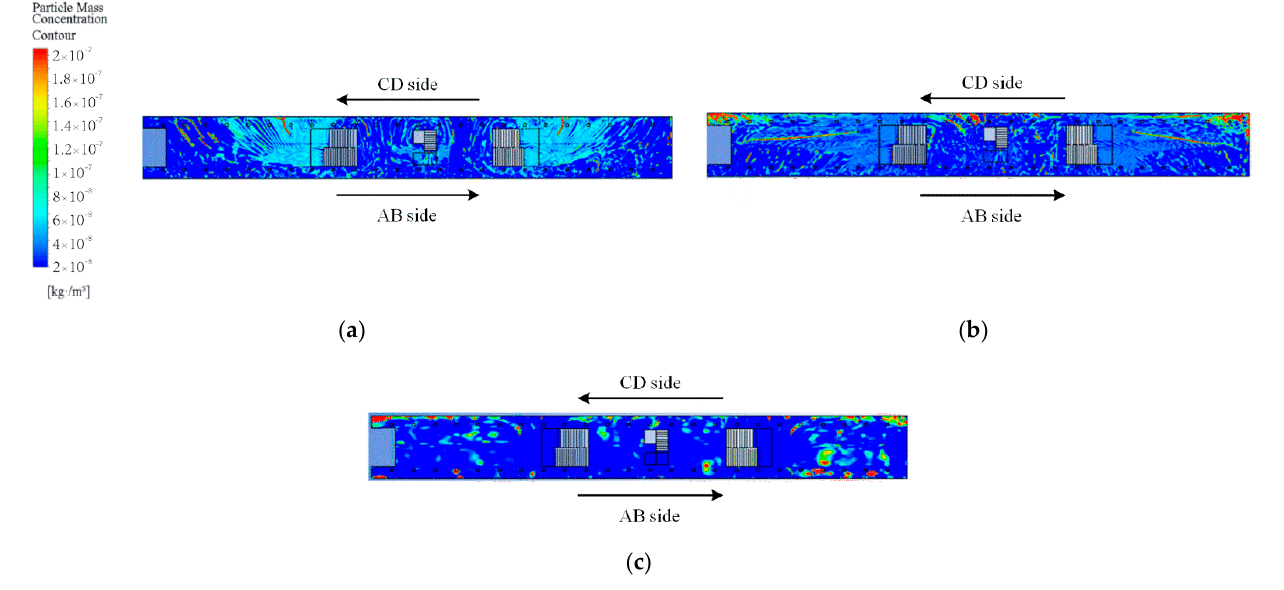
Figure 14. Simulation results of particle mass concentration contour at the station platform floor under different airflow organization: ( a ) AB side PSDs opened; ( b ) CD side PSDs opened; ( c ) PSDs closed.